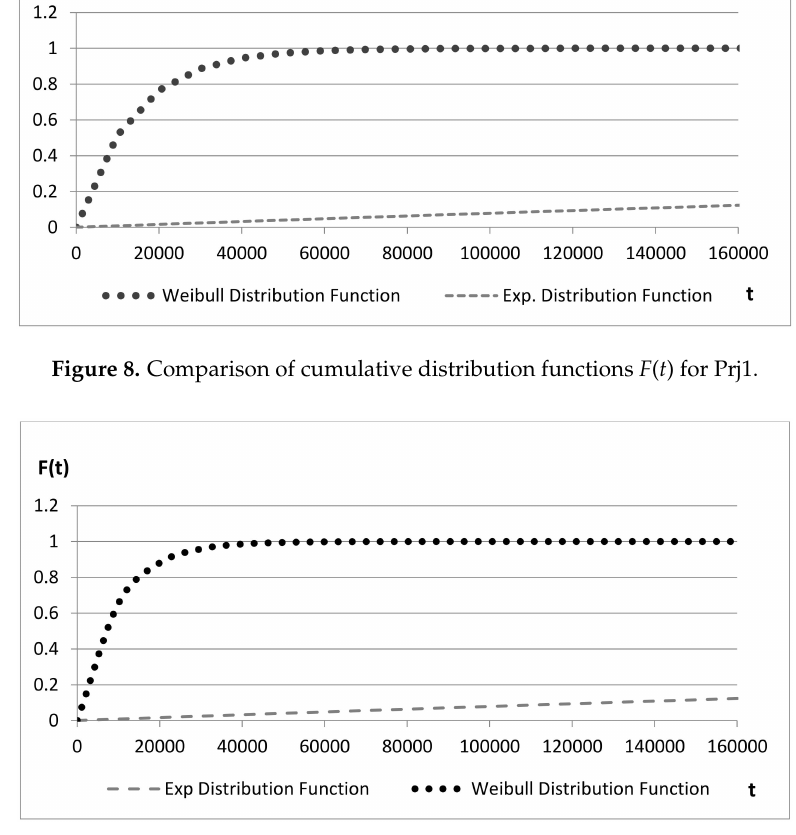
Figure 9. Comparison of cumulative distribution functions F ( t ) for Prj2.